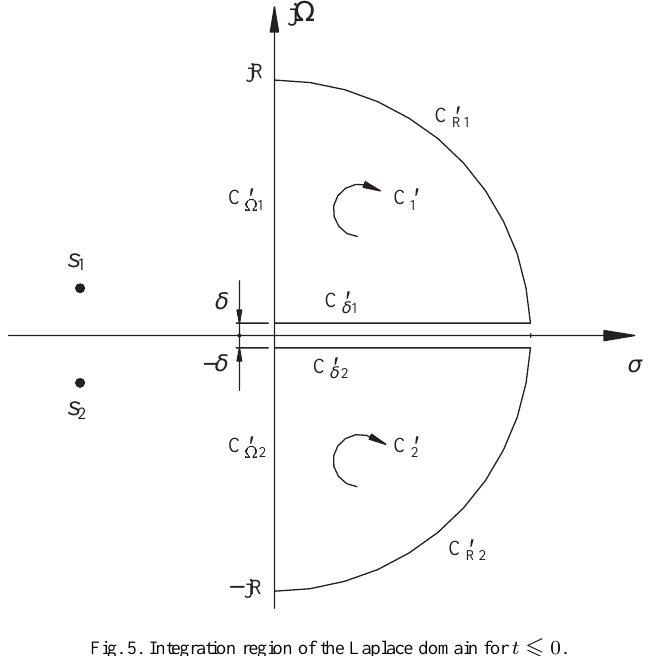
Fig. 5. Integration region of the Laplace domain for t (cid:2) 0